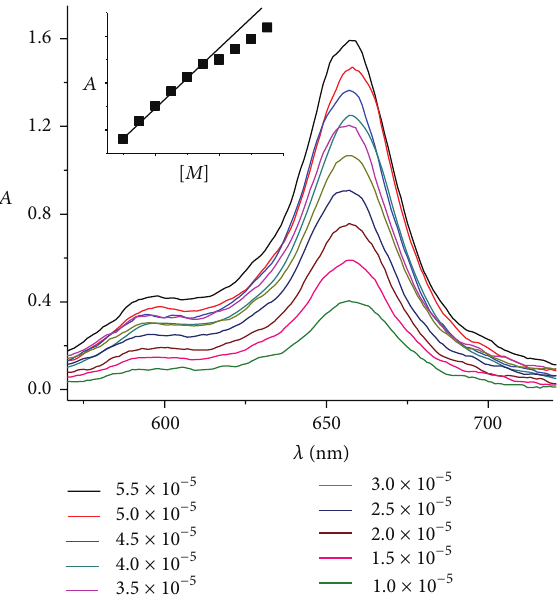
Figure 5: UV-Vis spectrum of CoPc in DMSO with different concentration (mol/L) (the inset is the relationship between the absorbance at maximum absorption wavelength and the concentra-